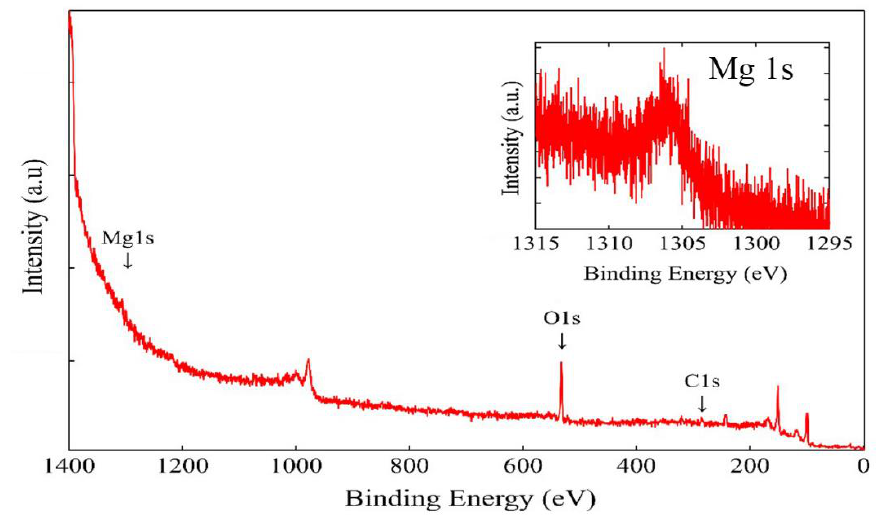
Figure 3. An XPS survey scan of the Mg thin film on Si(100). The inset is a high-resolution XPS spectrum of the Mg 1s core level state.